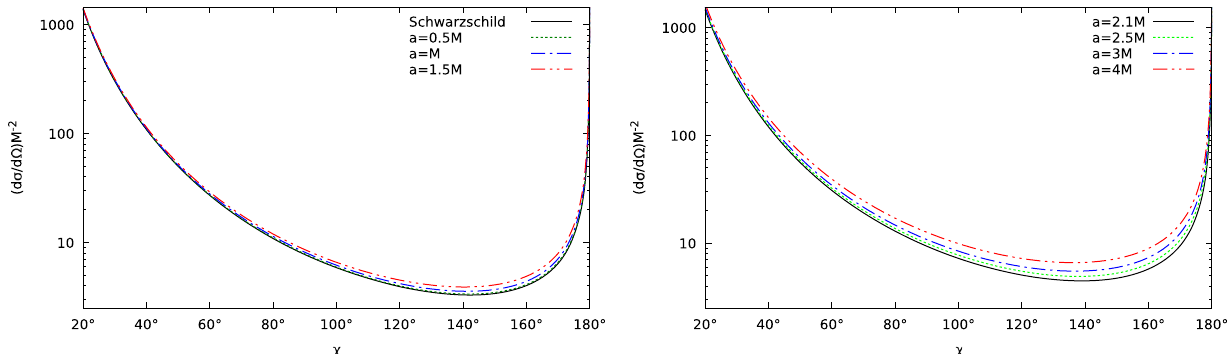
Fig. 1 The classical scattering cross section of massless particles by black holes (left panel) and wormholes (right panel) for different values of a / M . For the black hole case, we also show the Schwarzschild